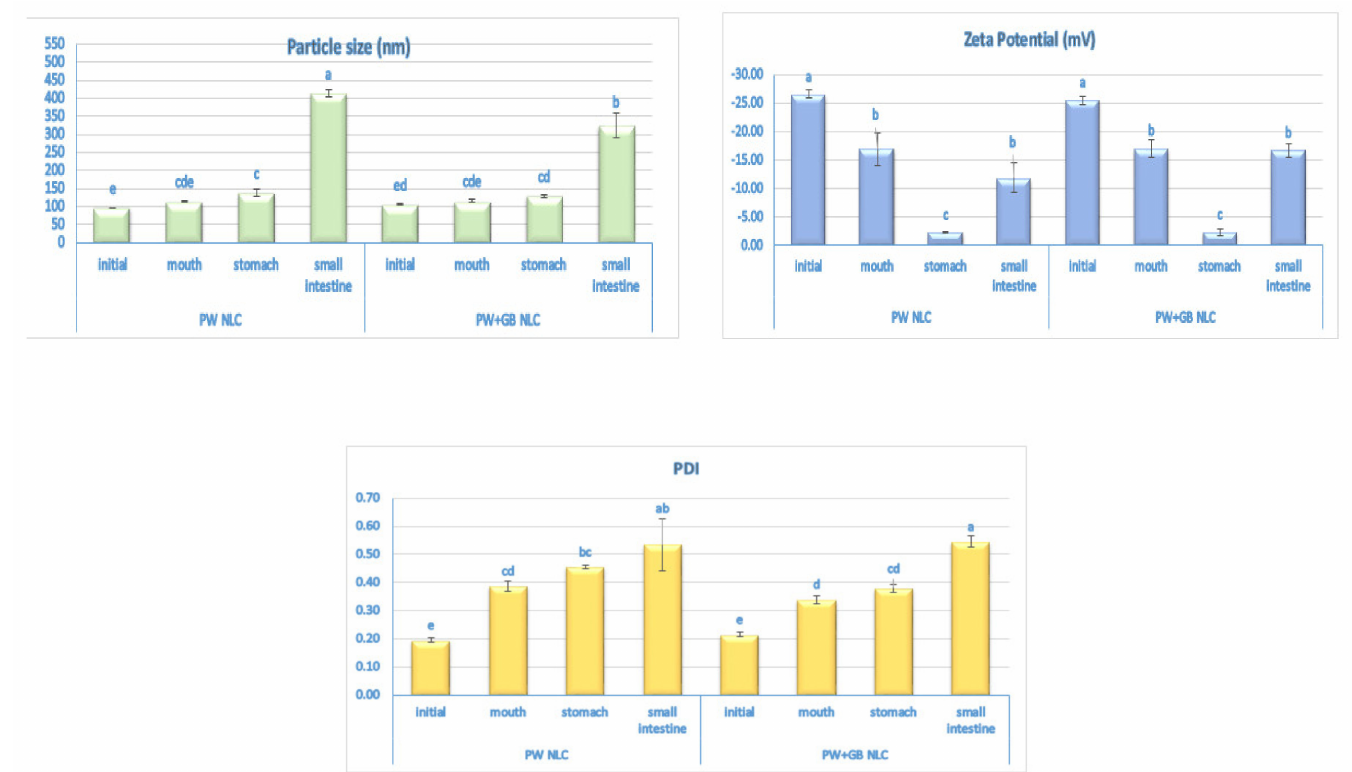
Figure 6. E ff ect of the di ff erent stages of the simulated gastrointestinal tract on the mean particle size, PDI, and surface charge of the β -sitosterol NLC dispersions. In each parameter, the means that have no superscript in common are significantly di ff erent from each other ( p ≤ 0.05). PW and PW + GB represent the NLCs formulated with propolis wax alone or its binary mixture with glyceryl behenate (1:1),